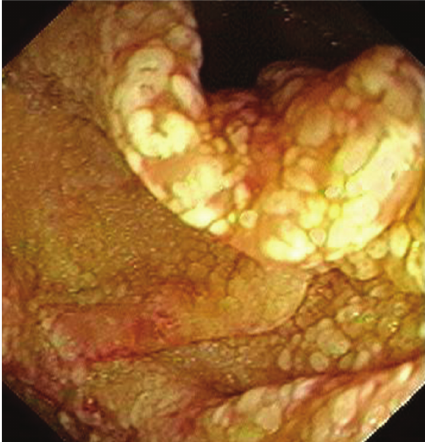
Figure 4: Whipple’s disease: detailed view on whitish plaques on the top of fold.